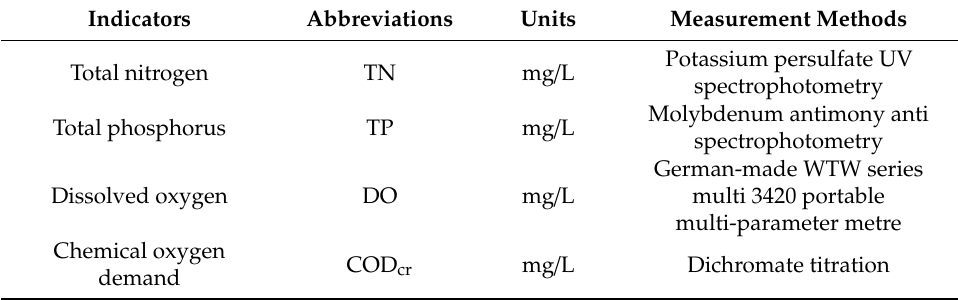
Table 1. Water quality indicators and the corresponding measurement